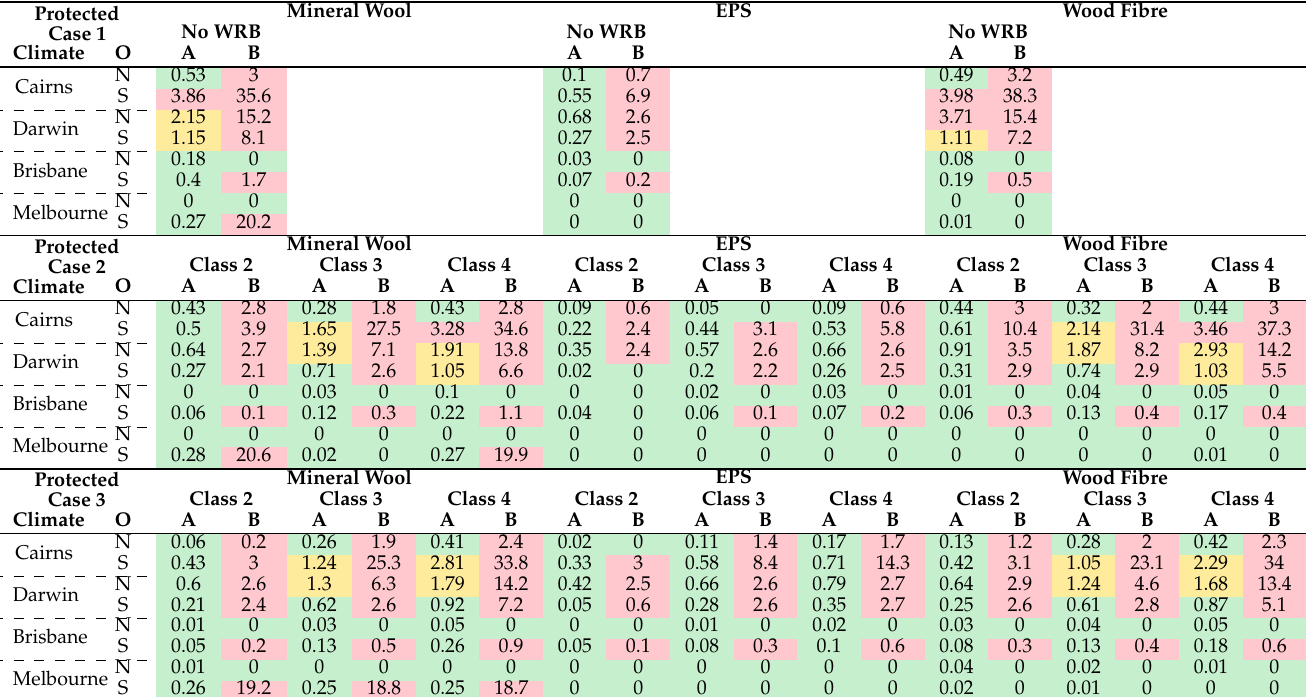
Figure 7. Wall assembly with insulation located both externally and internally. No WRB modelled (Case 1), WRB adhered to exterior of CLT panel (Case 2), and WRB installed to exterior of external insulation layer (Case 3). Red points represent the monitoring positions at the internal and external surface of the CLT panel. Table 10. Protected CLT results for split insulation. O (orientation). Performance criteria: A (mould growth index), B (corrosion rate). Classification of WRB: Class 2, 3, and 4 (vapour permeance). Green (pass), red (fail), or yellow (further